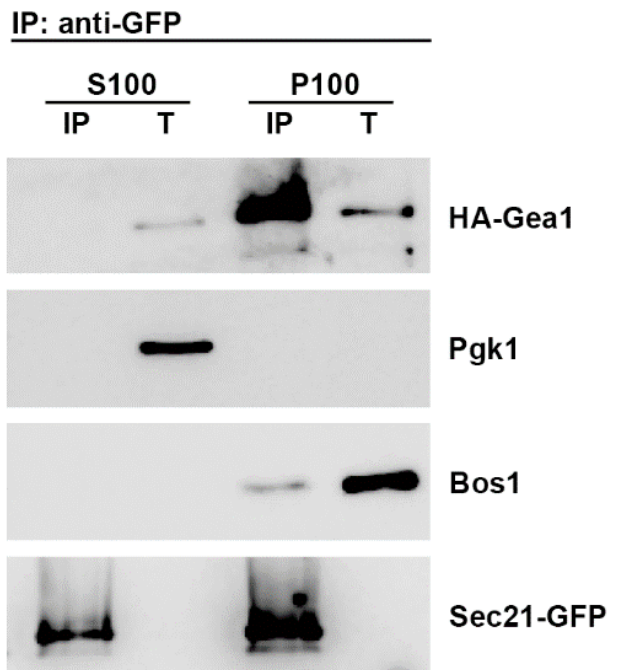
Figure 1. Gea1 and COPI coat specifically interact at the Golgi membrane. Total (T) lysate prepared from wild-type cells expressing HA-Gea1 and the COPI coat subunit Sec21 tagged with GFP was separated into low-speed supernatant (S13) and pellet (P13) fractions by a 13,000 × g centrifugation step. The S13 enriched-Golgi fraction was further separated into high-speed supernatant (S100) and pellet (P100) fractions by centrifugation at 100,000 × g . The collected fractions were subjected to specific immunoprecipitation for Sec21-GFP and subsequent immunoblotting using antisera to HA, Pgk1, Bos1 and